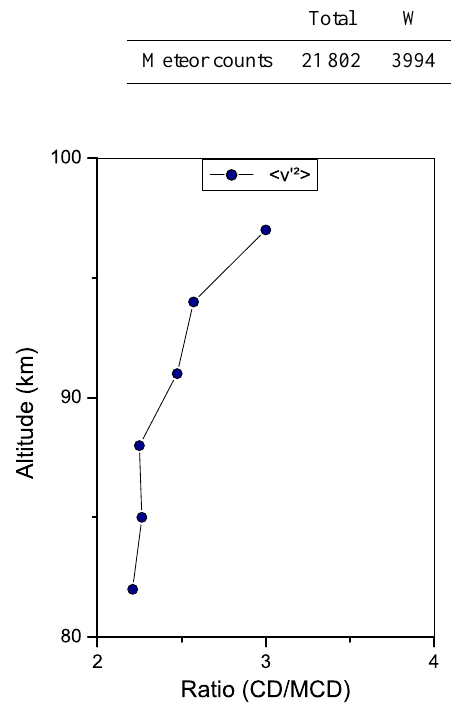
Fig. 5. Ratio of the composite to the modified composite day merid- ional